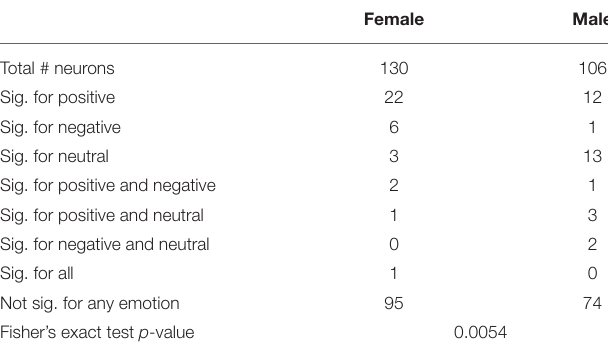
TABLE 5 | Neurons significant for specific emotions relative to background firing in the total amydala.